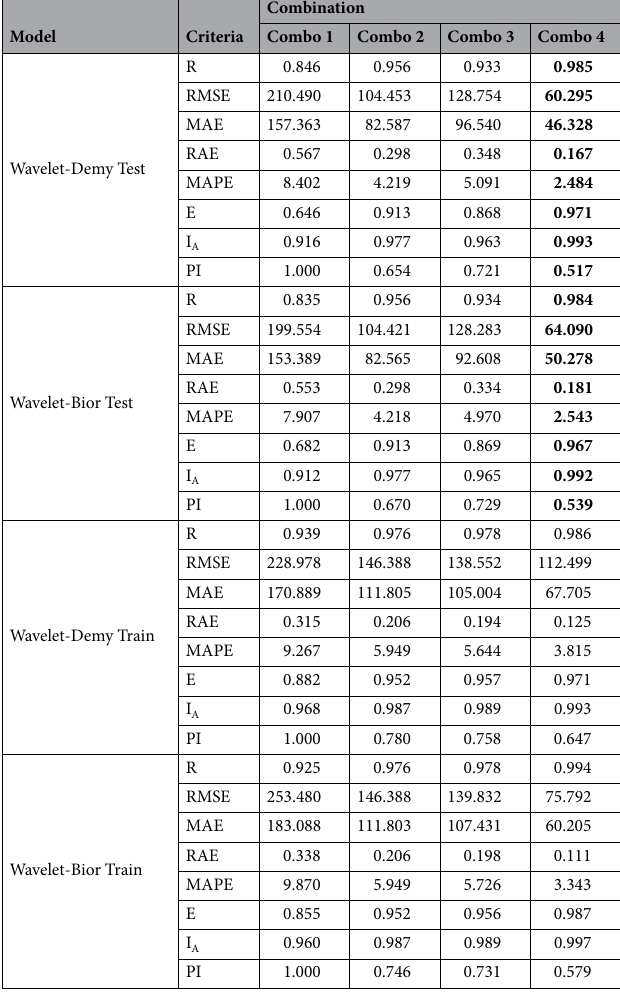
Table 8. Statistic metrics obtained by W-ANFIS model to forecast the EC parameter for all combinations. Significant values are in